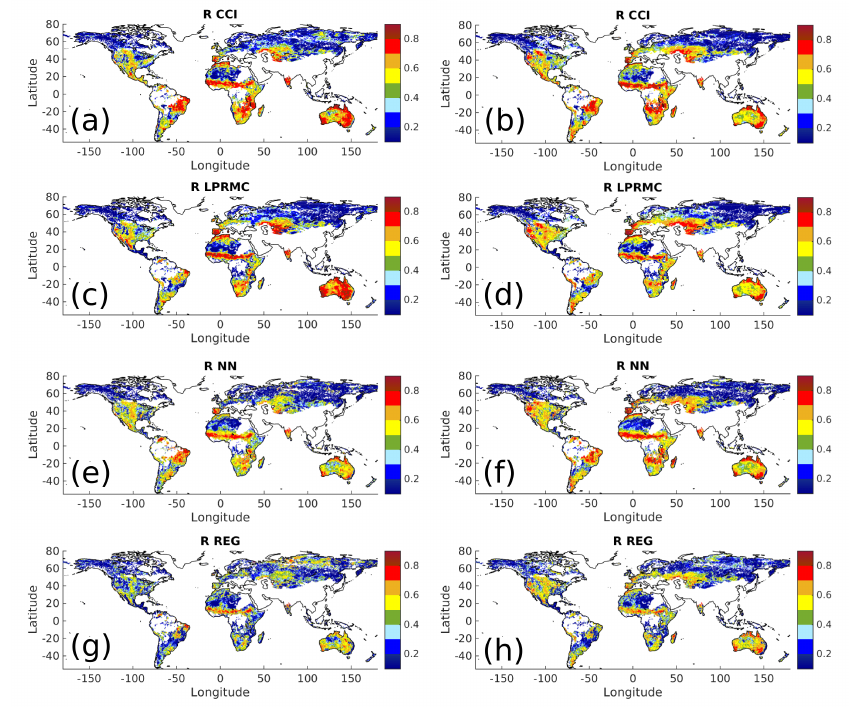
Figure 8. Pearson correlation of remote sensing products with respect to Modern-Era Retrospective analysis for Research and Applications-Land (MERRA-Land) (left panels) and ERA-Land (right panels). The remote sensing products evaluated are, from top to bottom: ESA CCI ( a , b ); AMSR-E LPRM C-Band ( c , d ); AMSR-E NN ( e , f ); and AMSR-E Reg ( g , h